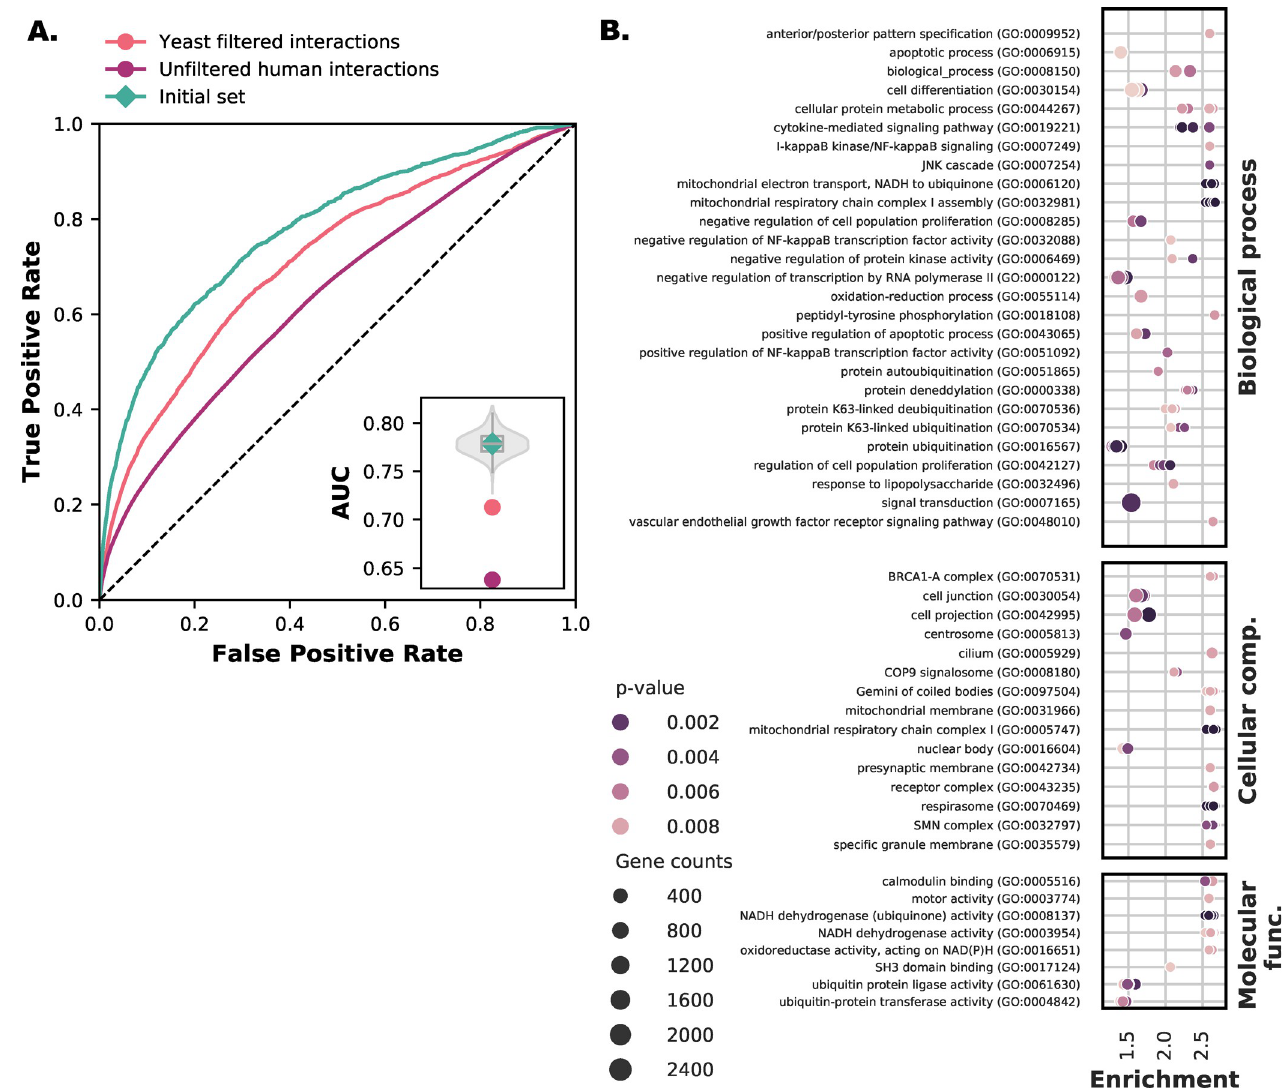
Fig 6. Interactome selection is important for prediction performance. A. Receiver-operator Curve of post-LECA OGs and unfiltered OGs. The inset gives the Area Under the Curve (AUC) values compared with the random backdrop of randomly selected LECA OGs (violin plot) and the initial species set (green diamond). B. GO-enrichment analysis for genes enriched in interactions present in only human compared to interactions present in human and yeast. OGs can contain multiple genes. We randomly selected genes from an OG to generate a new sample and population sets ten times and recalculated the enrichment (shown by multiple points in the figure rows). S11 Fig shows the results for Broccoli OGs.